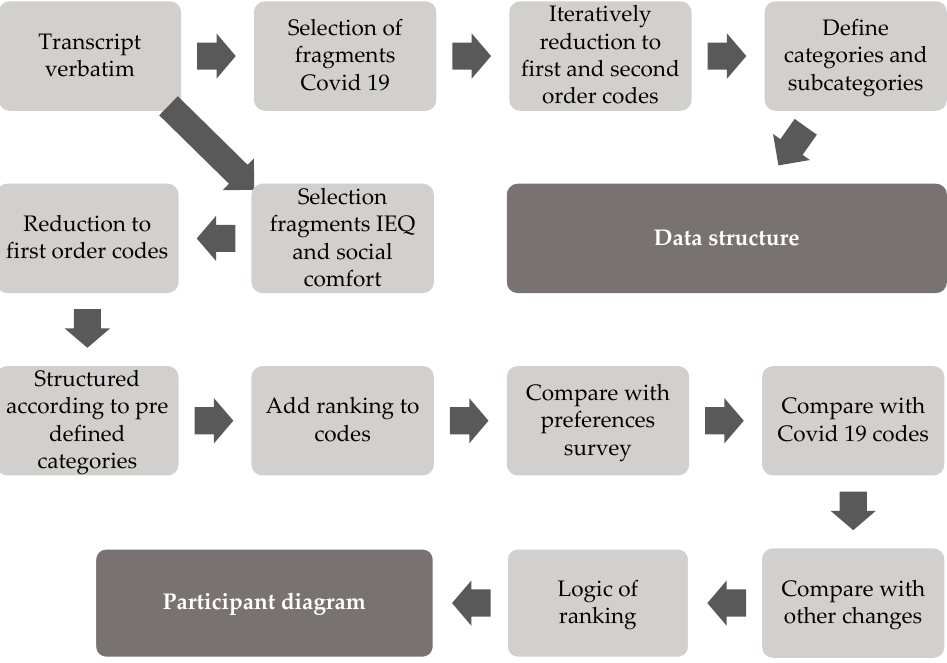
Figure 3. Steps for data analysis.